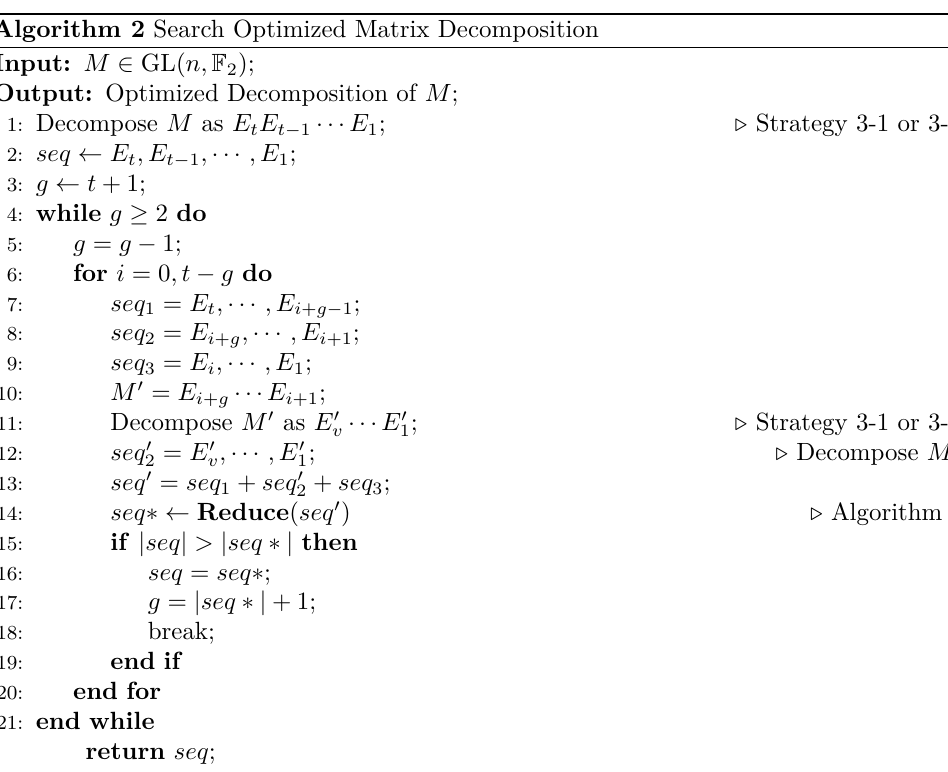
Algorithm 2 Search Optimized Matrix